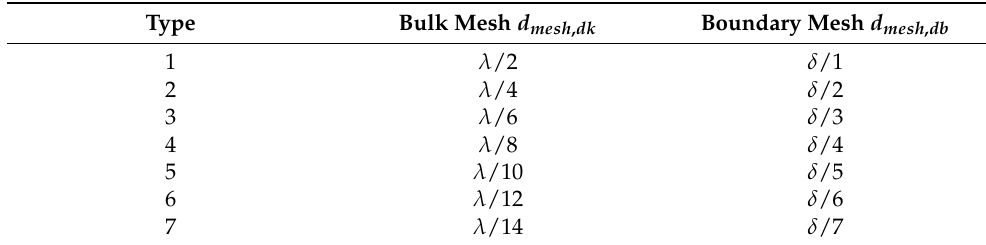
Table A1. Mesh size in fluid